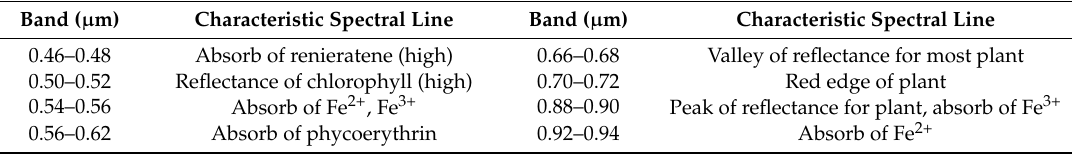
Table 2. Characteristic spectral lines of typical material in Visible and InfraRed band.